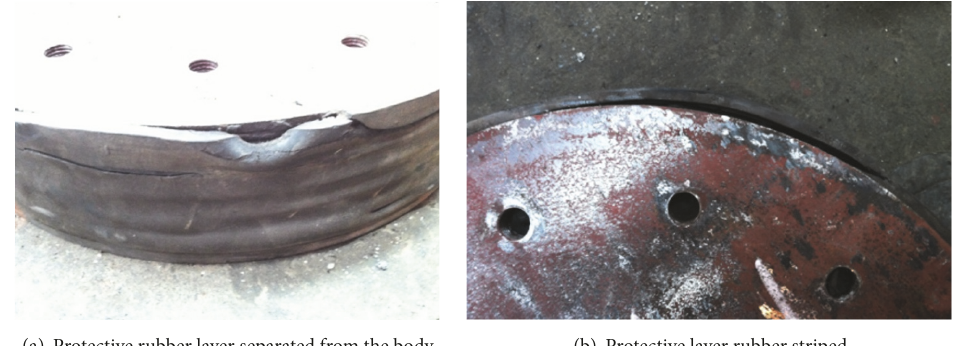
Figure 3: Partial failure of the bearing when 𝐸 = 200 %.